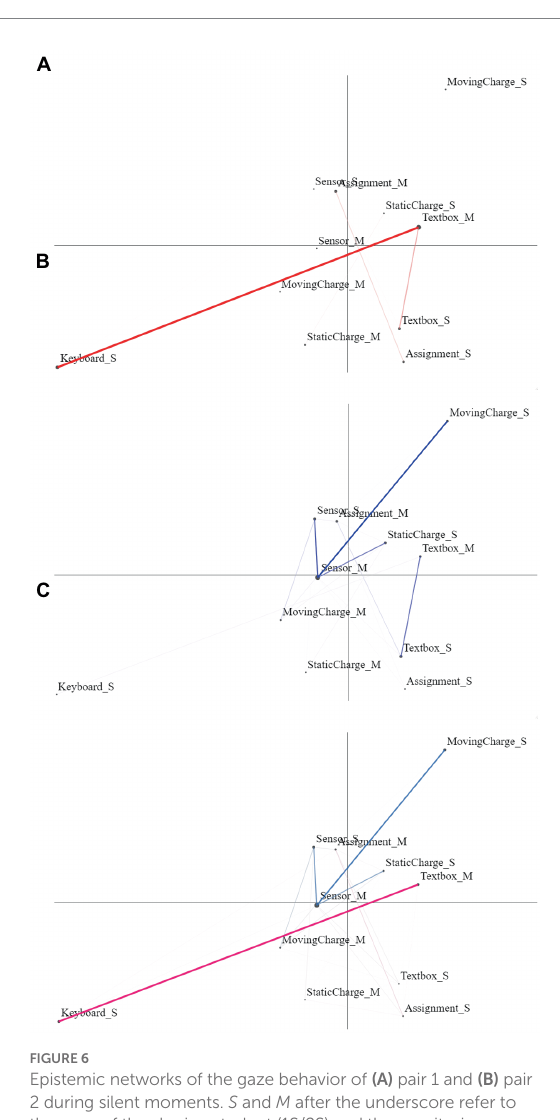
FIGURE 7 Epistemic networks of the gaze behavior of (A) pair 1 and (B) pair 2 during non-content-related talk. S and M after the underscore refer to the gaze of the sharing student (1S/2S) and monitoring student (1M/2M). The difference between epistemic networks (A,B) is presented in (C) . The red edges show the connections between the nodes that were stronger among pair 1 than pair 2. The blue edges show the connections between the nodes that were weaker among pair 1 than pair